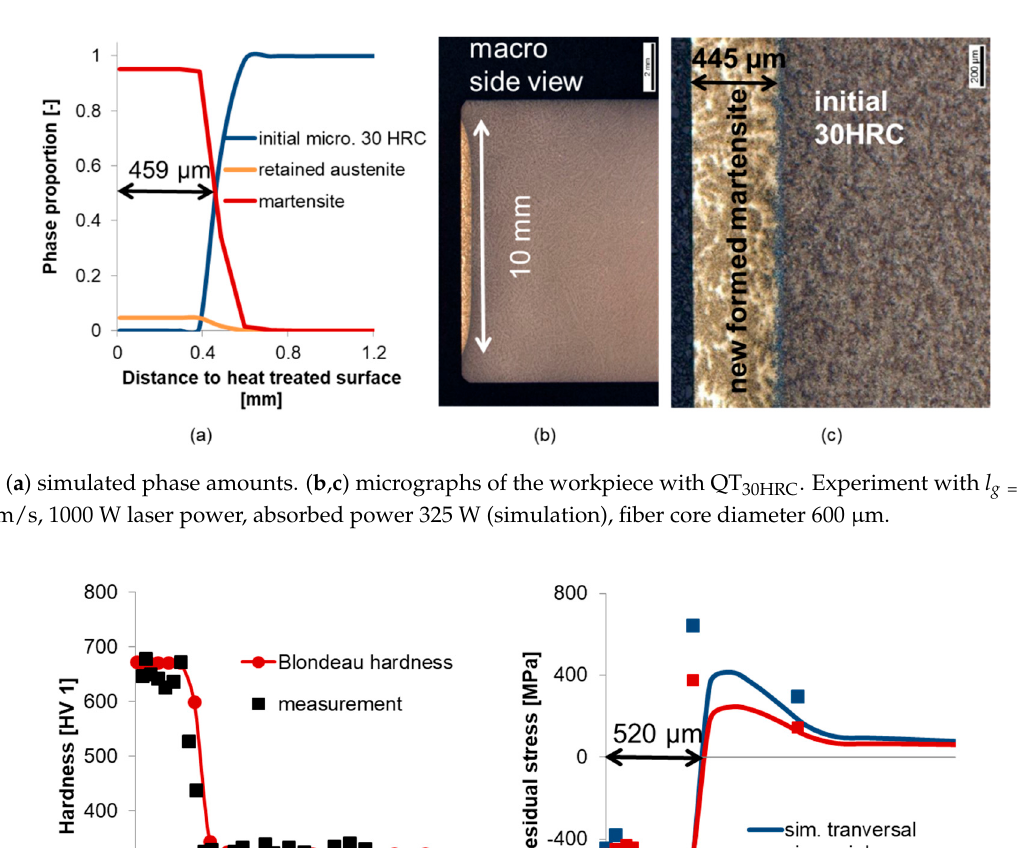
Figure 10. ( a ) Measured and simulated hardness and ( b ) residual stresses. QT 30HRC experiment with a Gaussian power profile ( l g = 1.48 mm), v ft = 2 mm/s, 1000 W laser power, absorbed total power P total = 325 W